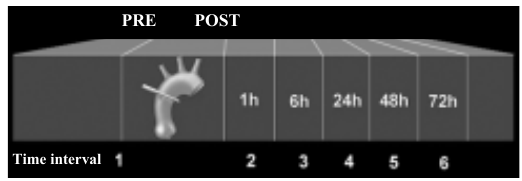
Circuit Scheme A - Venous reservoir